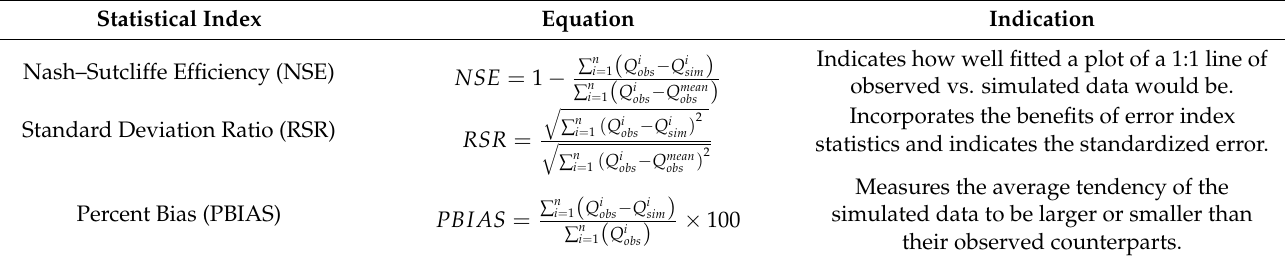
Table 7. Statistical indices for SWAT model [45,46].